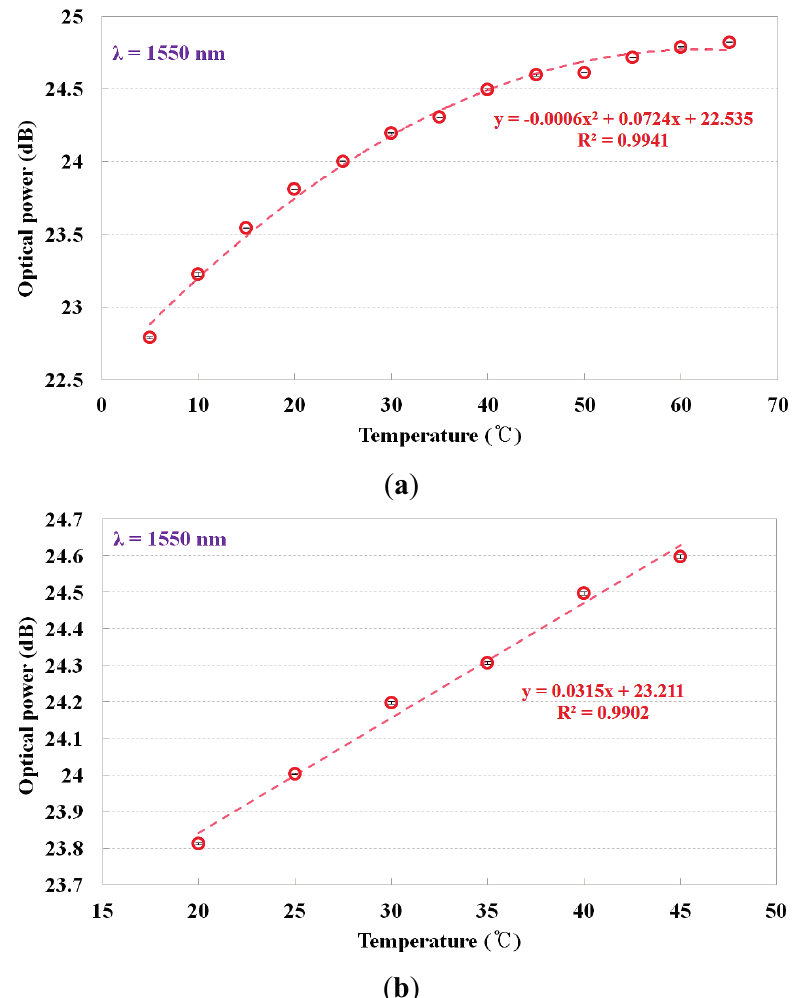
Figure 5. Relationship between the temperature of water and the optical power. ( a ) Water temperature in the broad range of 5 to 65 °C and ( b ) water temperature in the narrow range of 20 to 45